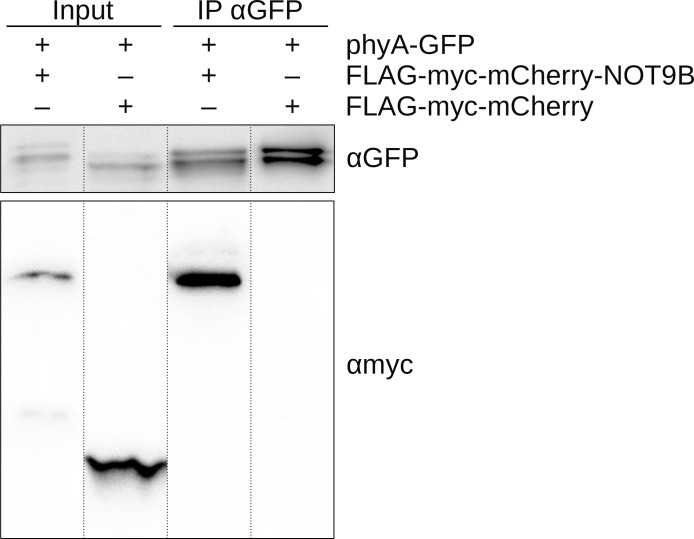
NOT9B co-precipitates with phyA in HEK293T cells.HEK293T cells were transfected with plasmids coding for phyA-GFP and either FLAG-myc-mCherry-NOT9B or FLAG-myc-mCherry. Medium was supplemented with 20 μM PCB. Total soluble protein was extracted, and CoIP was performed using αGFP magnetic beads. Input and eluate fractions were analysed by SDS-PAGE and immunoblotting with αGFP and αmyc antibodies. The figure is assembled from different lanes of the same membrane (dashed lines).